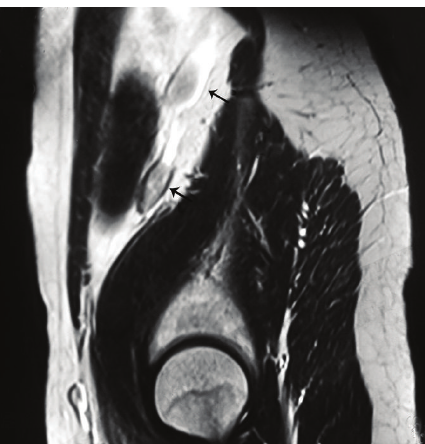
Figure 1: MRI T2, sagittal cuts showing 2 oblong masses in the left retroperitoneum.